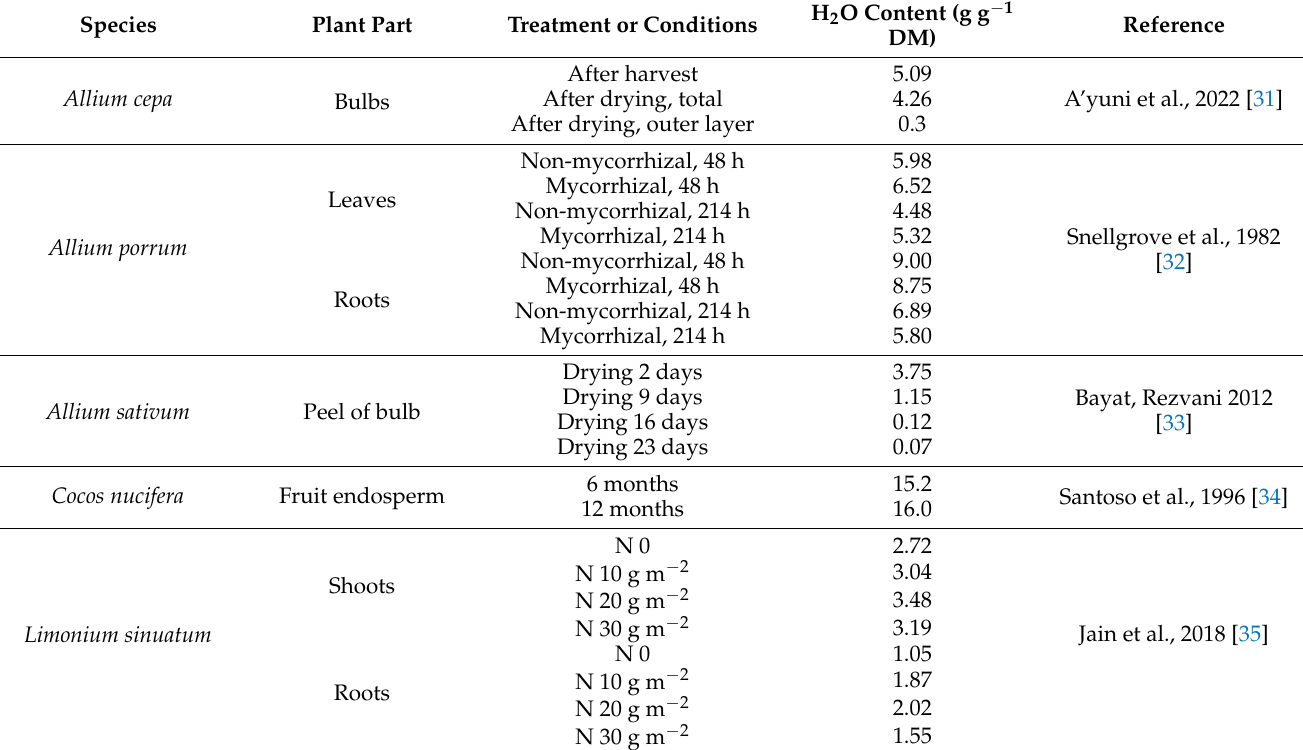
Table 1. Examples of differences in tissue water content values in various plant species and